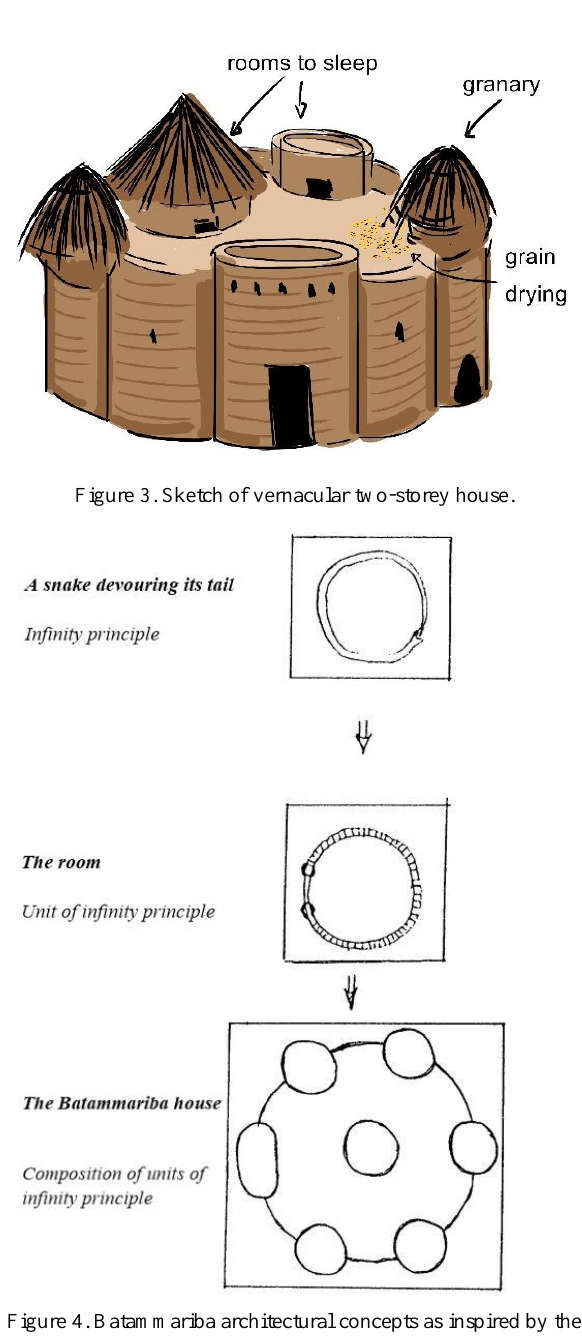
Figure 4. Batammariba architectural concepts as inspired by the circular form (Yavo, 2013).